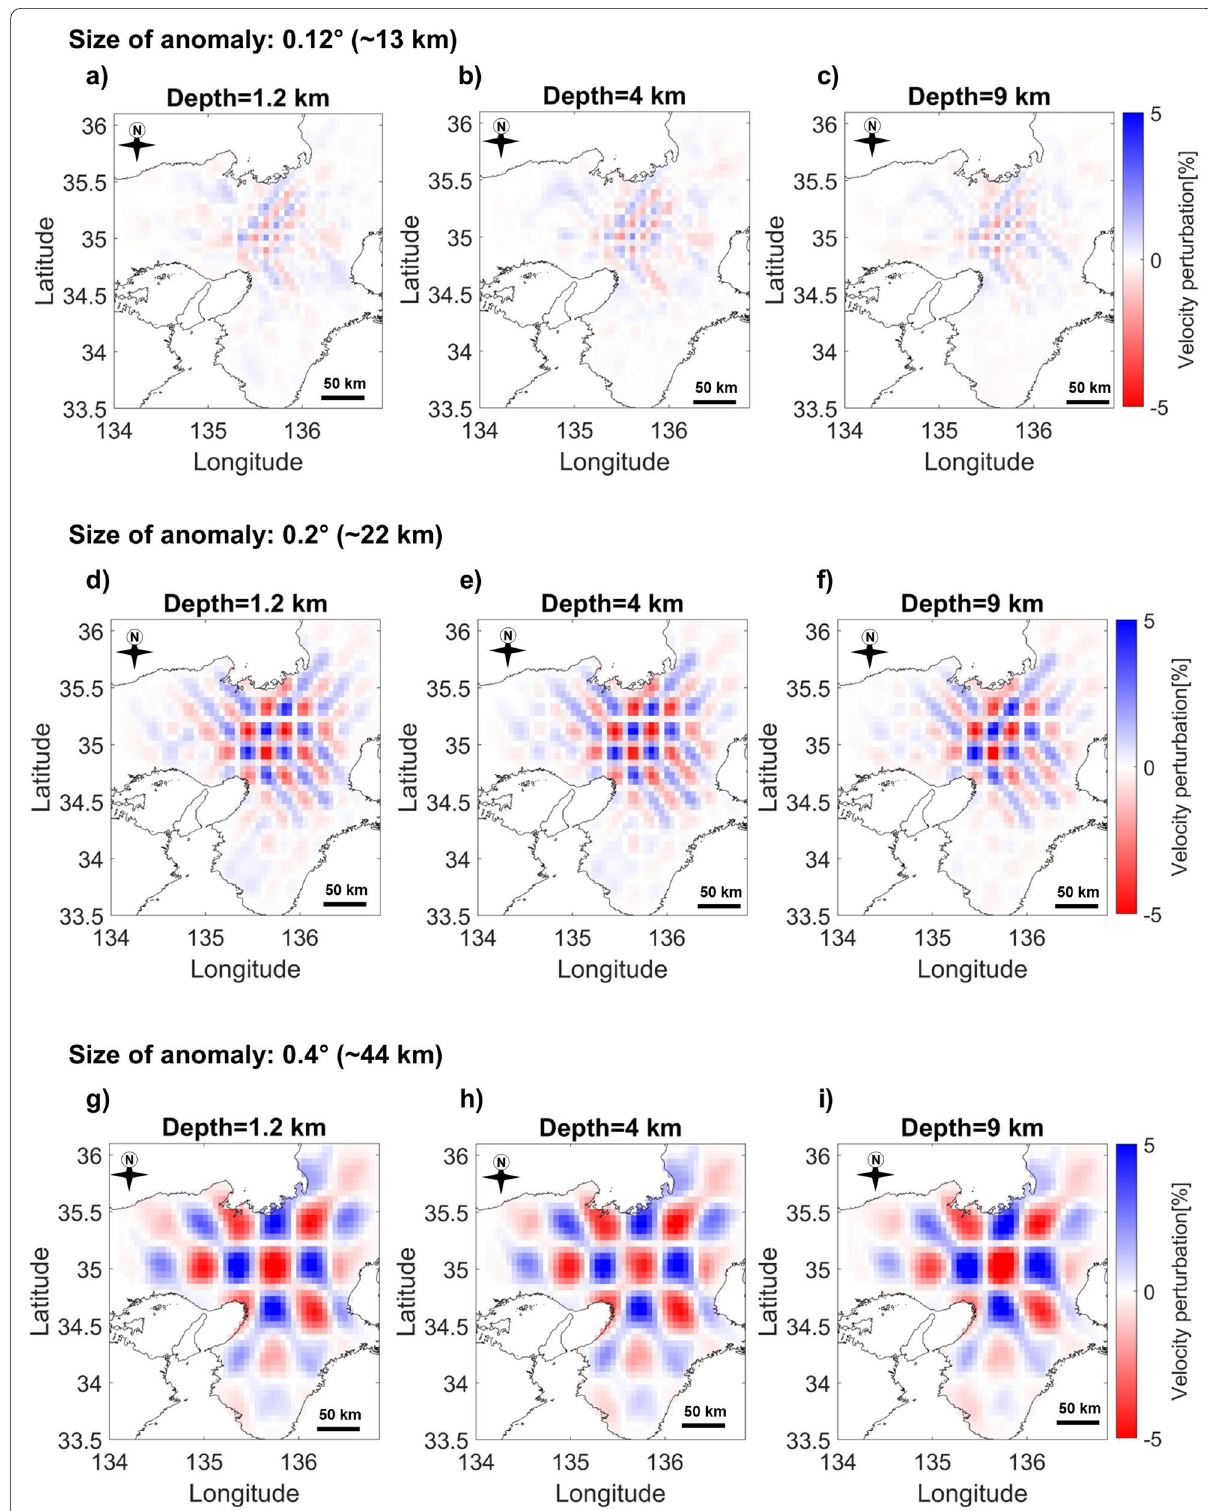
Fig. 6 Horizontal velocity perturbation slices of the checkerboard resolution test results with anomalies of three different sizes: a – c anomaly size of 0.12° (~ 13 km), d–f anomaly size of 0.2° (~ 22 km), and g–i anomaly size of 0.4° (~ 44 km). The velocity amplitude was ~ 5%. Depth is shown above each horizontal